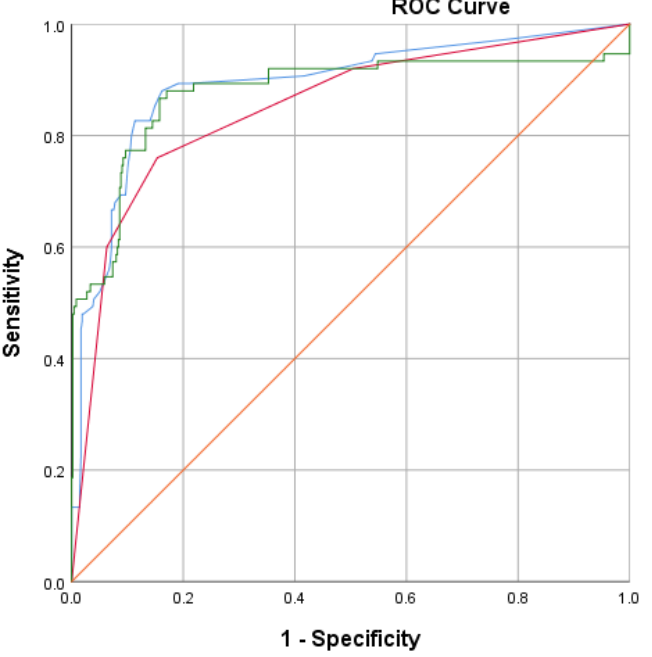
Figure 9. ROC curves of the logistic model, decision tree model, and random forest model.